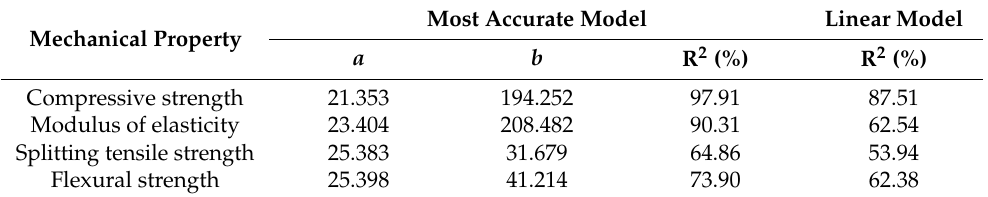
Table 3. Simple-regression